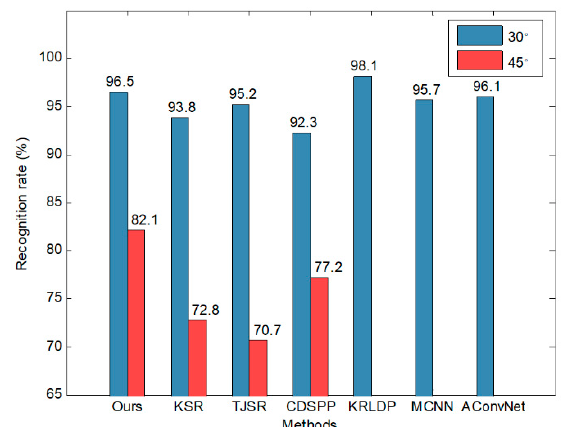
Figure 10. Comparison of different methods under the depression angle test. KRLDP, MCNN, and A-ConvNet only provide recognition results for a depression angle of 30°.